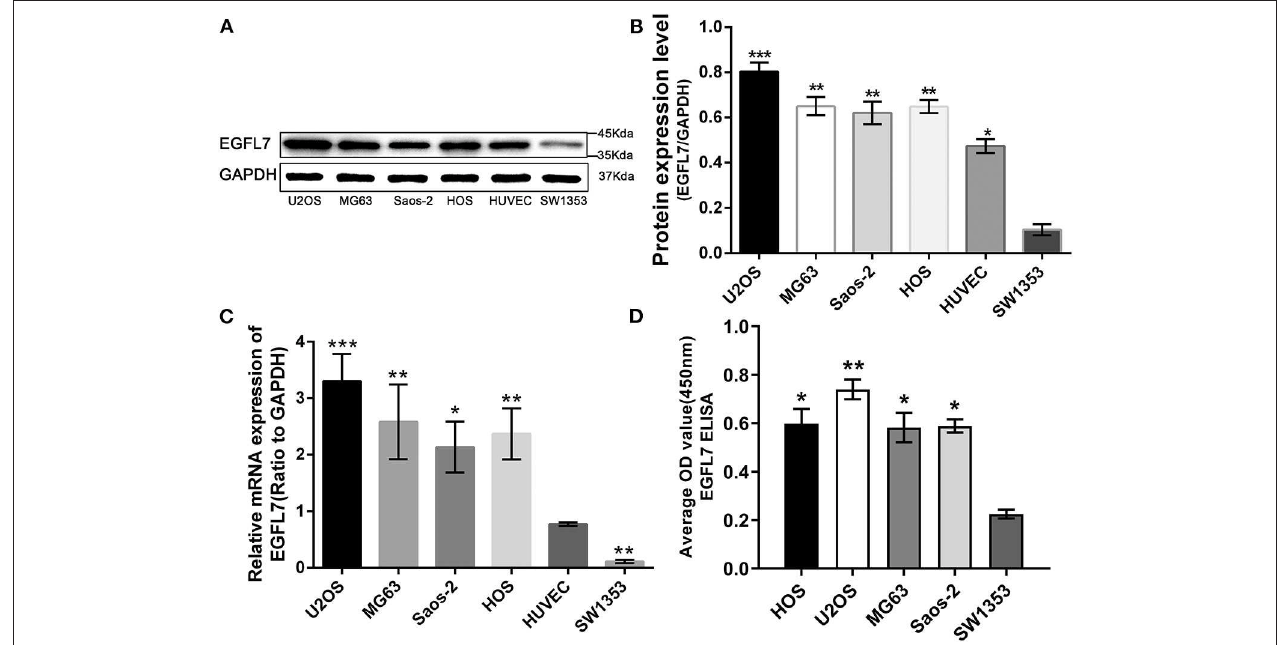
FIGURE 2 | Upregulation of EGFL7 expression in OS cell line compared with ECs and CS cell line. (A,B) Western blot results showed that EGFL7 protein was overexpressed in all OS cell lines and HUVECs compared to SW1353. Statistical analysis showed that the expression of EGFL7 in OS cell lines was significantly different from that in SW1353. Similarly, the expression of EGFL7 protein in HUVEC was significantly different from that in SW1353. (C) RT-PCR results showed that the transcription level of EGFL7 mRNA in OS cell lines was significantly higher than HUVEC, there are also differences between HUVEC and SW1353, and the difference was all statistically significant. PCR and western blot experiments were all performed in triplicate. (D) The ELISA results of EGFL7 in cell culture medium also confirmed that there was indeed a high expression of EGFL7 protein in osteosarcoma cells. * P < 0.05, ** P < 0.01, *** P < 0.001.